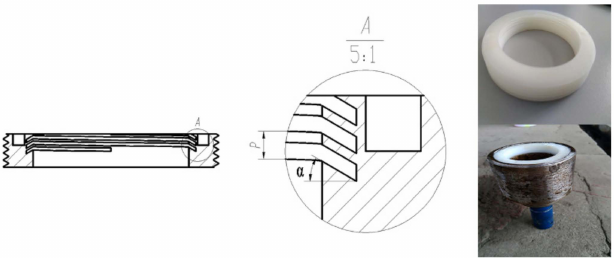
Figure 5. Helical shaft